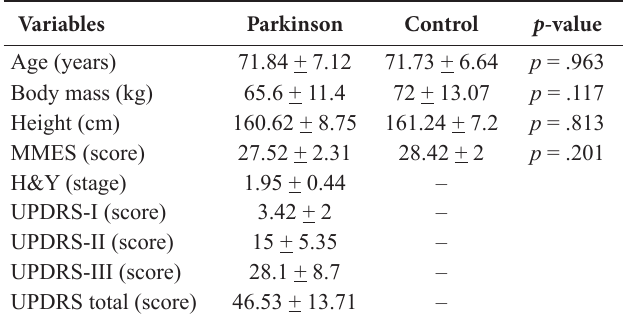
Table 1. Means ± standard deviations of the demographic data for each group and clinical data for PD